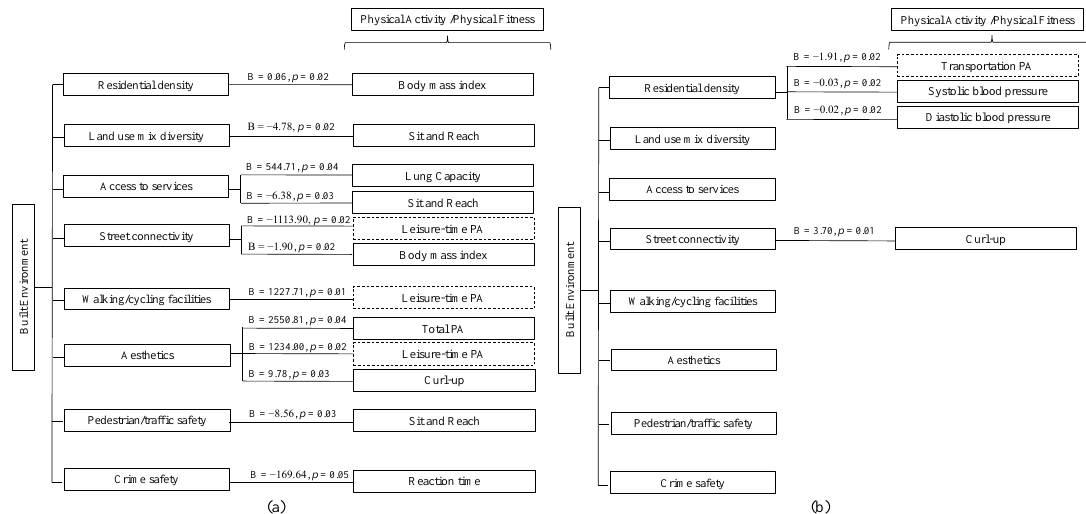
Figure 1. Summary of association between built environment attributes and physical activity / physical fitness variables in men and women living inside the city wall of Xi’an. PA indicates physical activity. ( a ) Is for men and ( b ) is for women. Solid lines indicate the built environment attributes and physical fitness variables, dashed lines indicate the physical activity